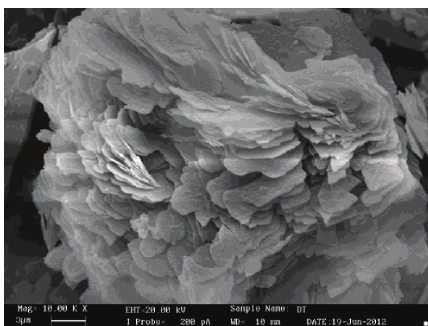
Figure 2: SEM morphgraph of